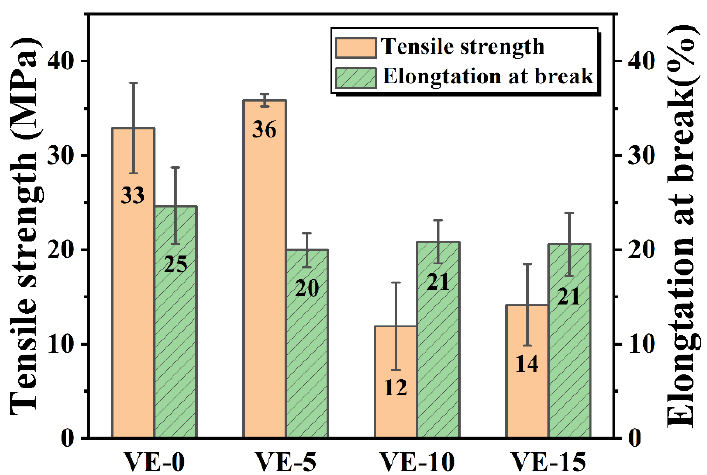
Figure 3. Strength and elongation at break of VE composites.